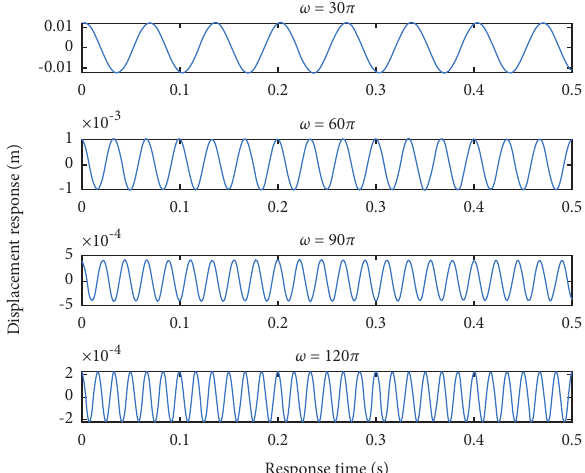
Figure 16: Time-domain response of the auxiliary beam under different excitation frequencies.